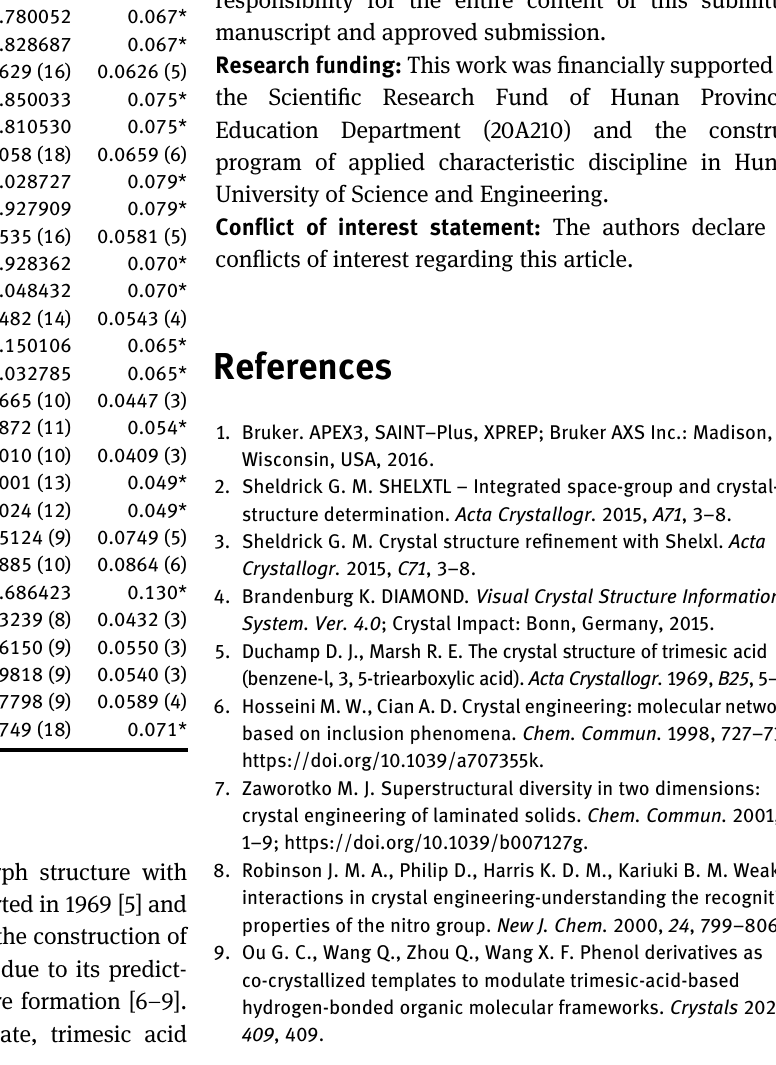
The title compound was synthesized by the reaction of trimesic acid with macrocylic L. X-ray crystal structural analysis reveals that the asymmetric unit of the title structure contains half L 2 + and one [C Two macrocylic L 2 + and two 3,5-dicarboxybenzoate anions are interconnected to form a tetragonal holes through O – H ⋯ O hydrogen bonding interactions. The tetragonal holes further interacted with each other to form two-dimensional hydrogen-bonded networks.